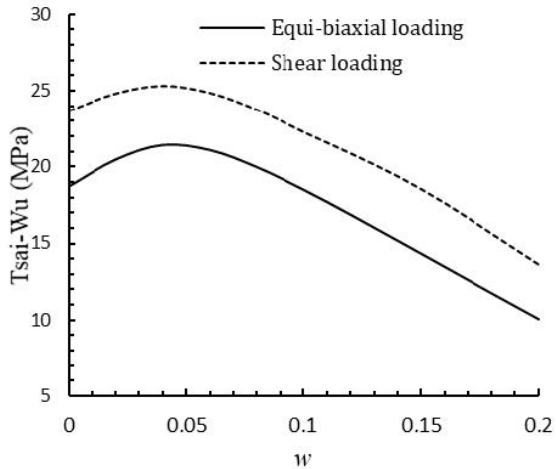
Figure 20. Strength variations of the graphite/epoxy with w ( c = 1).